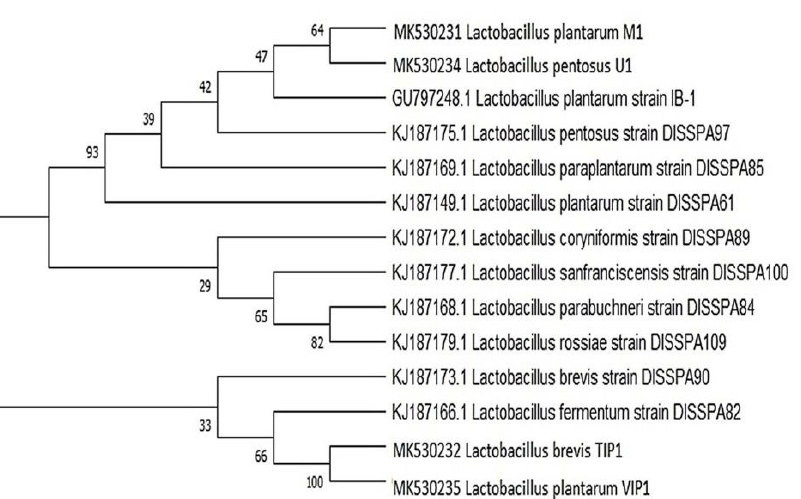
Fig. 1. Phylogenetic tree of Lactobacillus isolates. It was inferred using Neighbor-Joining method showing the position of isolates and related strains based on 16S rRNA gene sequence. The number at the starting of each genus indicates an accession number obtained from the NCBI database. The evolutionary distance were computed using the Masximum composite Likehood method. The evolutionary analysis was conducted in MEGA